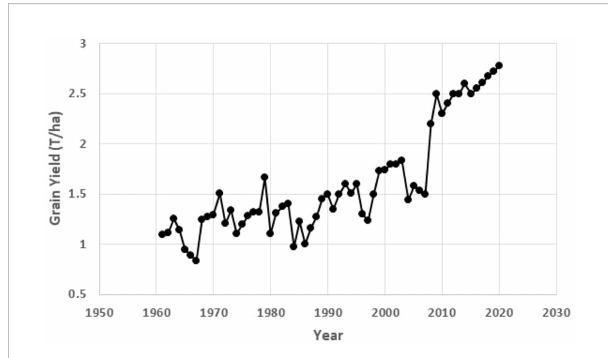
FIGURE 2 Annual grain yield of maize in Uganda using data from FAO